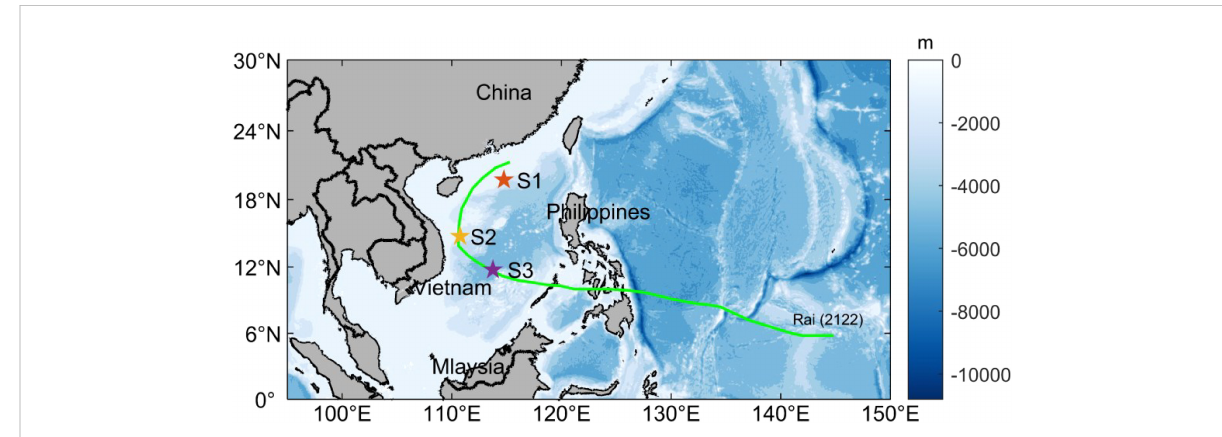
FIGURE 1 Location distribution of stations S1, S2, and S3, the green curve represents the path of Typhoon